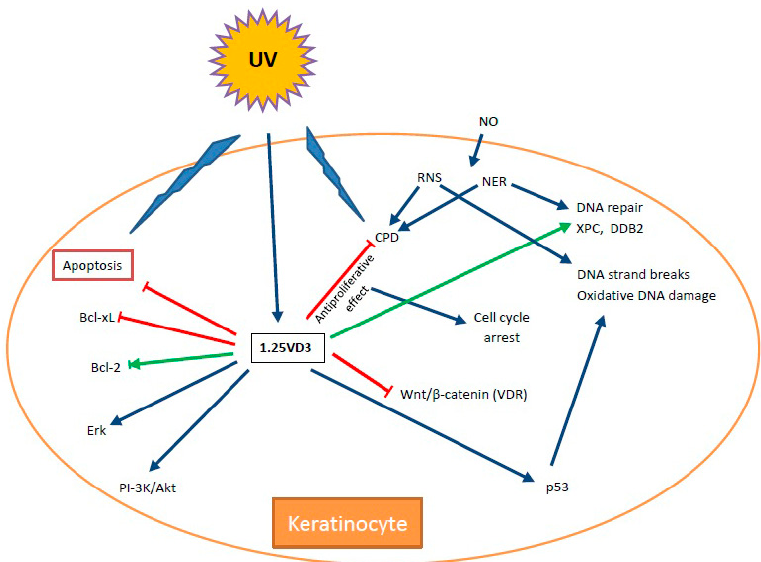
Figure 5. Some pathways and interactions important for the involvement of vitamin D3 in DNA damage response (DDR). UV radiation can induce DNA damage, which here is represented by the cyclobutane pyrimidine dimer (CPD). It can also directly induce apoptosis and stimulate the production of 1,2-dihydroxywitamin D3, an active metabolite of vitamin D3, which can, in turn, affect various aspects of DDR as described in text. Green sharp arrows—activation, red blunt arrows—inhibition, dark blue sharp arrows—general influence. NO: nitric oxide; RNS: reactive nitrogen species; NER: nucleotide excision repair.